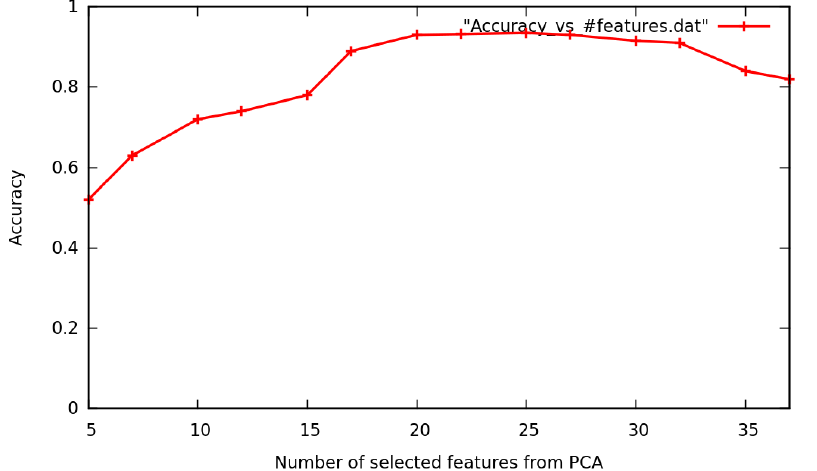
Figure 9. GNB classifier’s accuracy depending on the number of selected features from